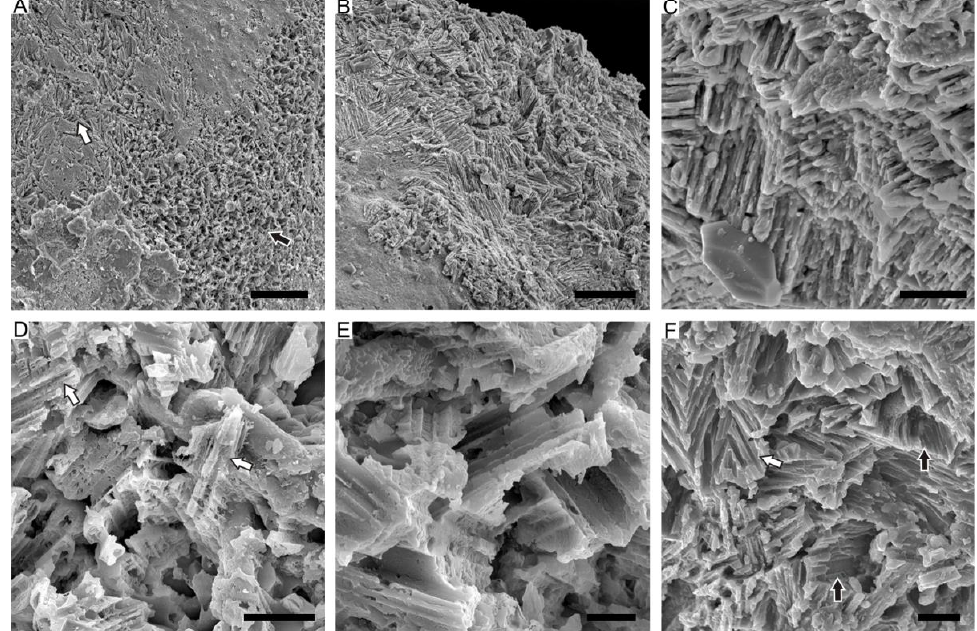
Figure 6. The irregularly oriented crisscrossed prismatic microstructure of early Cambrian Postacanthella shells. ( A ) Specimen NRM Mo196860, fibrous appearance and preservation of horizontally oriented (white arrow) and vertically oriented (black arrow) prisms on surface of phosphatic internal mold specimen. ( B ) Specimen NRM Mo196861, irregular orientation of mineral prisms. ( C ) Specimen NRM Mo196862, individual prisms intersect and overlap with adjacent prisms. ( D , E ) Specimen NRM Mo196867, irregular orientations of mineral prisms. ( F ) Specimen NRM Mo196863, individual prisms show second-order sub-structural units (black and white arrows). Scale bars: 50 μm ( A ), 20 μm ( B ), 5 μm ( C , D ), and 3 μm ( E , F ).